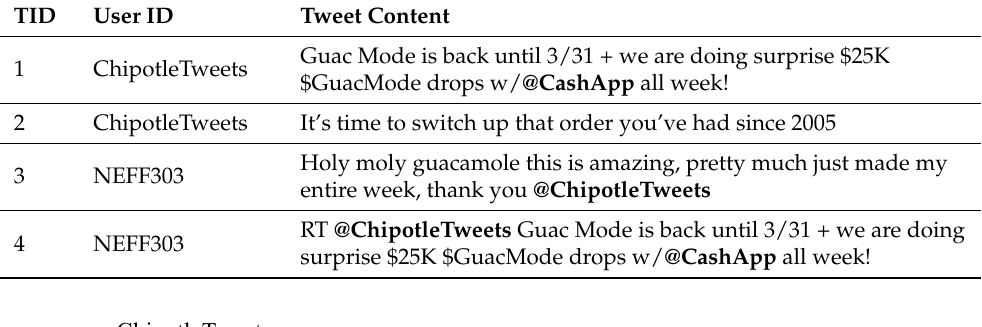
Table 1. Example of extracting interaction graph.